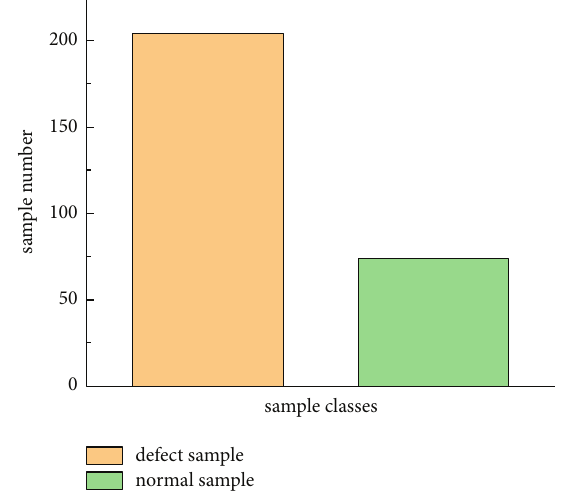
Figure 7: Sample situation of wheelset tread.